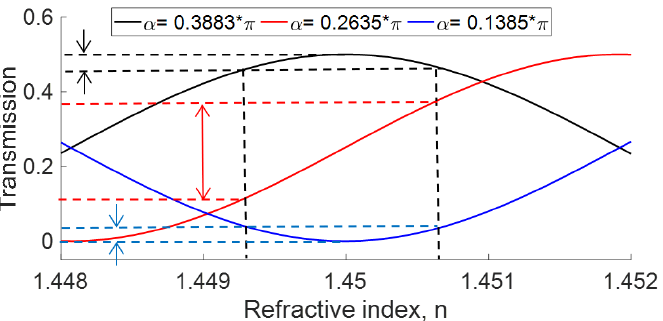
Figure 3. Dependence of Sagnac transmission on refractive index in the loop, for different values of QWR angle α . Double arrows illustrate the amplitude of transmission variations resulting from a given index fluctuation. The symbol (*) denotes